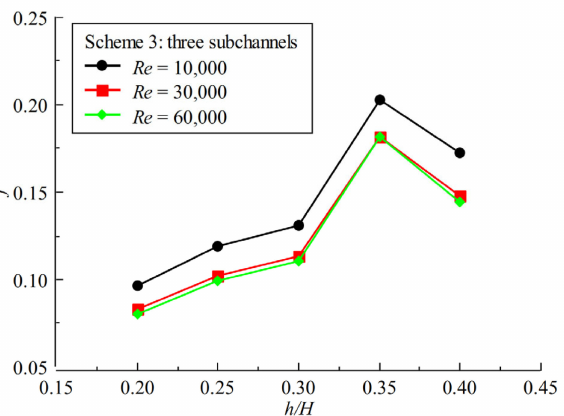
Figure 7. Effects of h/H on the flow performance of X-shaped truss array channels of Scheme 3 at different Reynolds